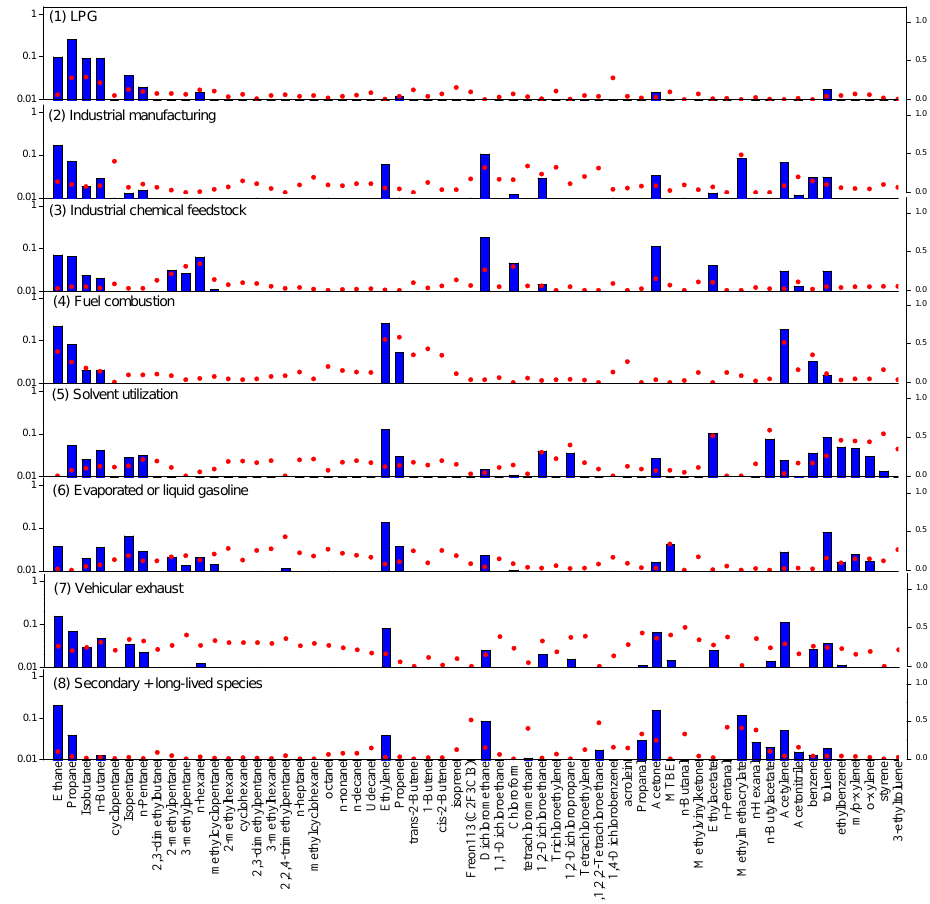
Figure 7. Eight source profiles (bars; ppbvppbv − 1 ) resolved from PMF model, and contribution percentages (dots) from each source factor.